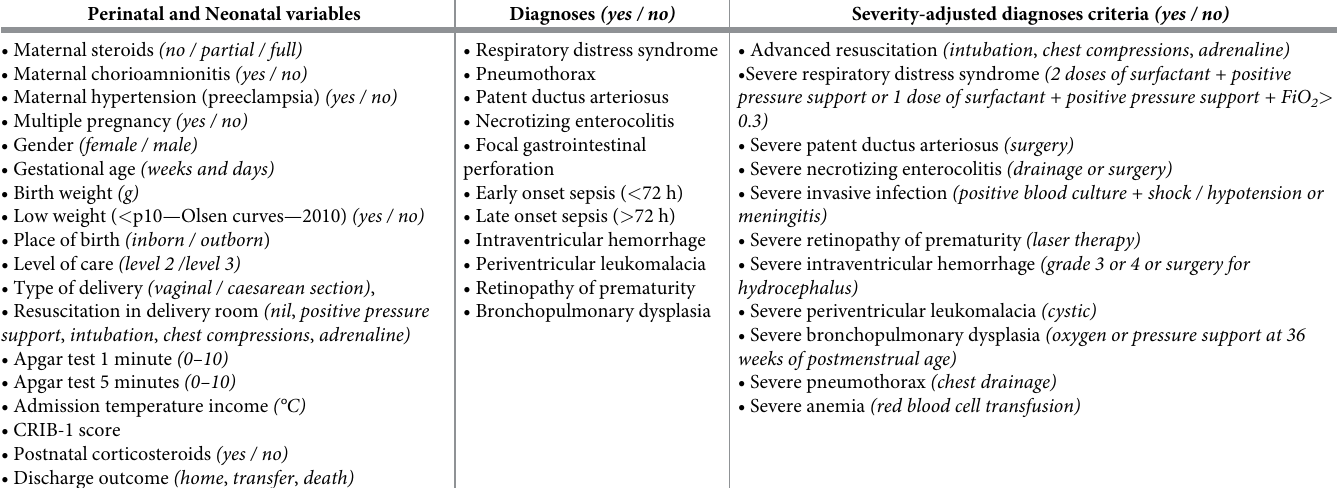
Table 1. Variables and diagnoses used in predictive models of